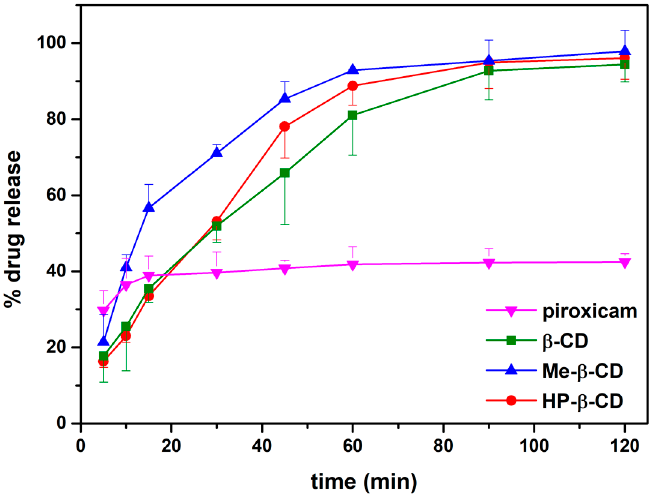
Figure 5. In vitro release studies of pure piroxicam and binary systems in tablet form ( n = 3).